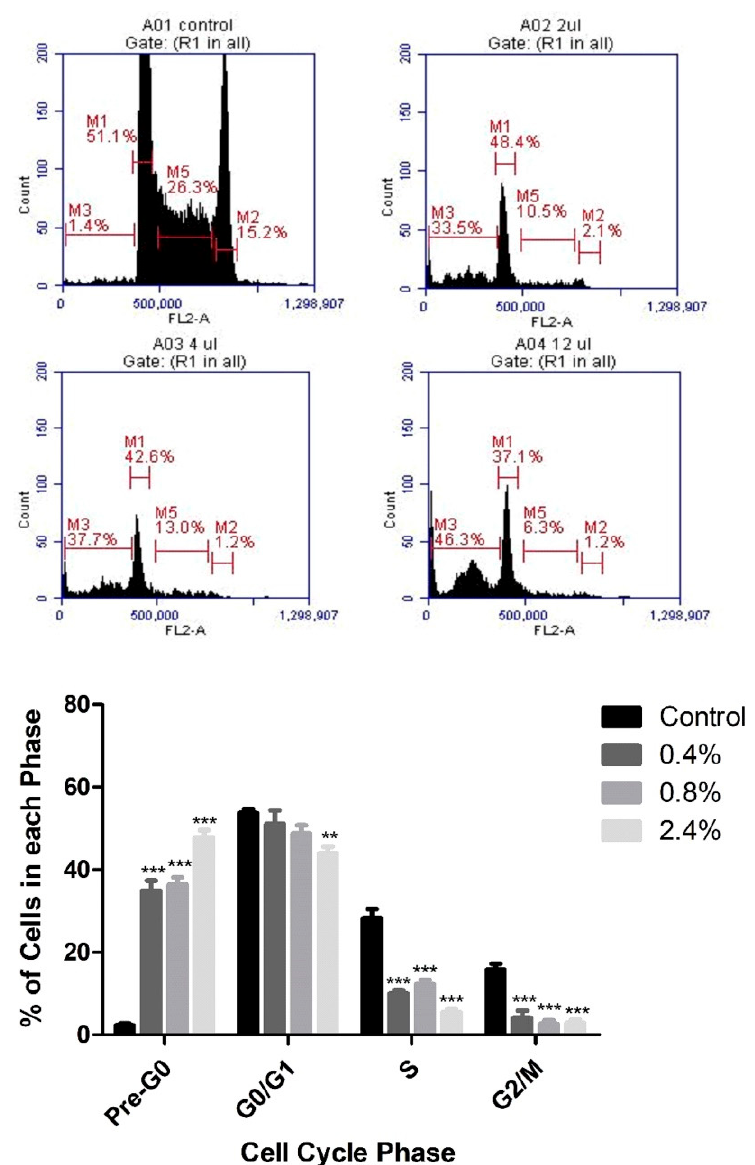
Figure 4. Dose-dependent effect of UD extract on cell-cycle distribution of U937 cells after 72 h treatment. Cells are distributed into the different phases of the cell cycle according to their DNA content: pre-G0 cells are <2n (M3), G0/G1 cells are 2n (M1), S cells are >2n but <4n (M5), and G2/M-phase cells are 4n (M2). The histogram represents the means from three independent experiments +/ − SEM. *, **, and *** indicate p < 0.05, p < 0.001, and p < 0.0001, respectively, compared to the control group.